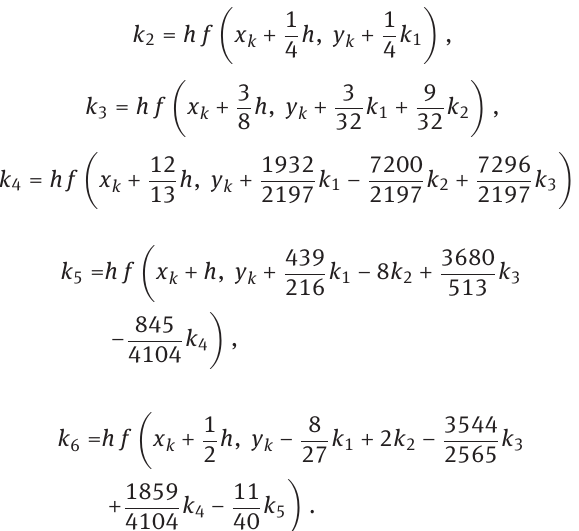
particular case n = 1, i.e. viscous fluid for different val- ues of thermocapillarity number M 1 = 0.0 and 0.5, when M = Nr = ϵ = Q = Ec = 0 and Fig. 2 shows an excellent agreement with